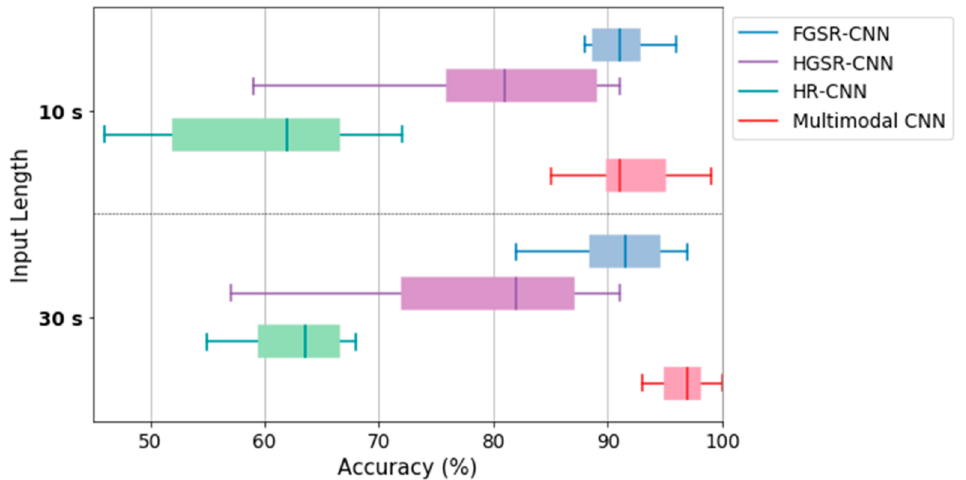
Figure 8. Comparison of the performance variations of our multimodal CNN model and three unimodal CNNs for FGSR, HGSR and HR signals depending on input signal length and sensor type.